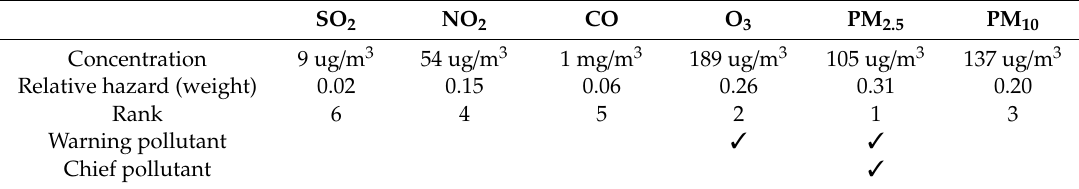
Table 3. Evaluation results of Normalized Secondary-Level Limit Weighting (NSLLW) on 17 April 2019 in